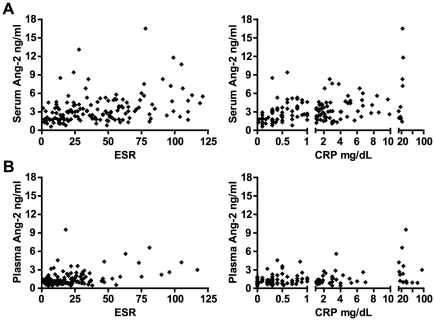
Plots of angiopoietin-2 (Ang-2) levels versus markers of systemic inflammation.
A. Serum Ang-2 versus ESR (left panel) and CRP (right panel) in the RAVE trial. Values at screening, when each patient had severe disease (BVAS/WG≥3), are shown. B. Plasma Ang-2 versus ESR (left panel) and CRP (right panel) in the VCRC longitudinal study. Note that patients in remission (BVAS/WG = 0) are included, and that Ang-2 levels are lower in plasma than in serum.